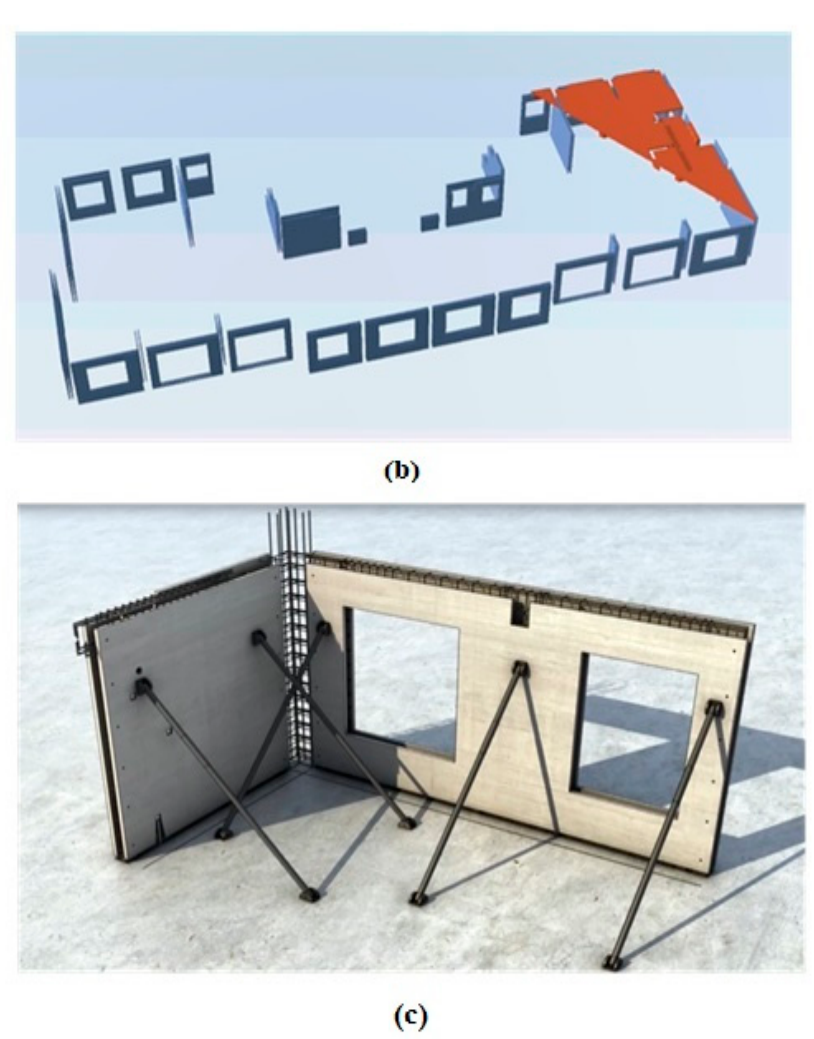
Figure 3. ( a ) The BIM model for the prefabrication project; ( b ) prefabrication components; ( c ) an example of prefabrication wall panel supported on the construction site.